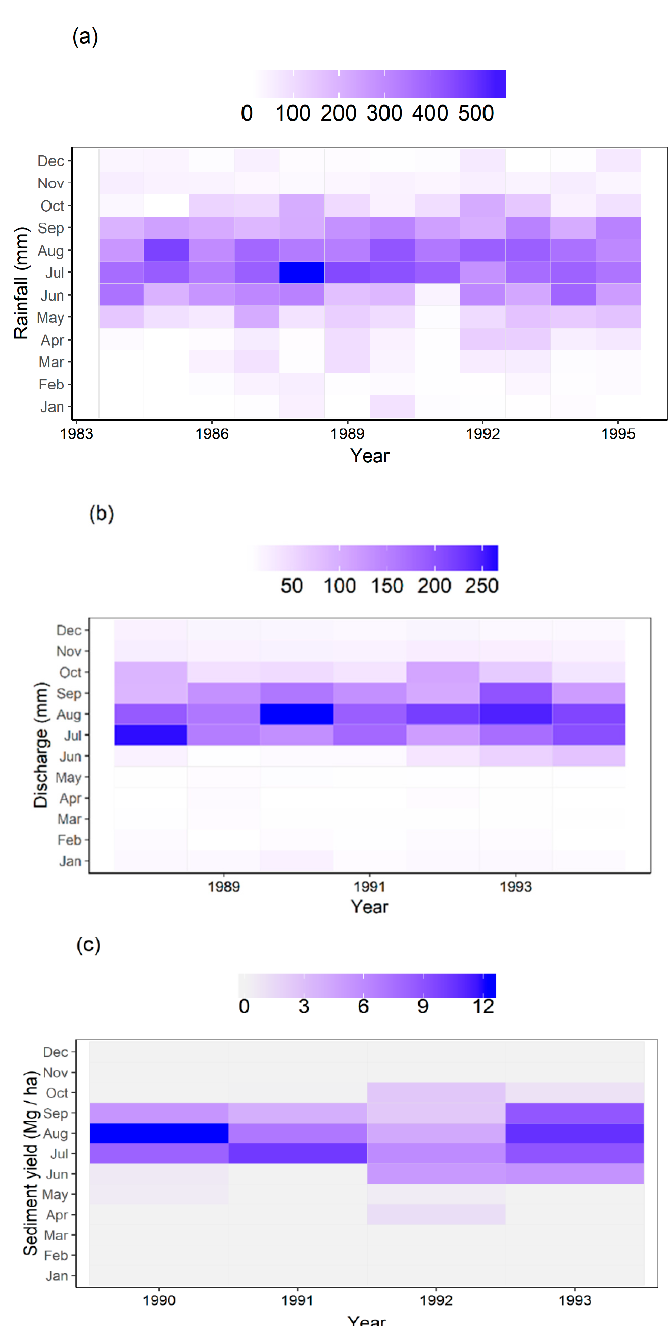
Figure 4. Long-term monthly average rainfall ( a ), discharge ( b ), and sediment yield records ( c ) at the Anjeni watershed.